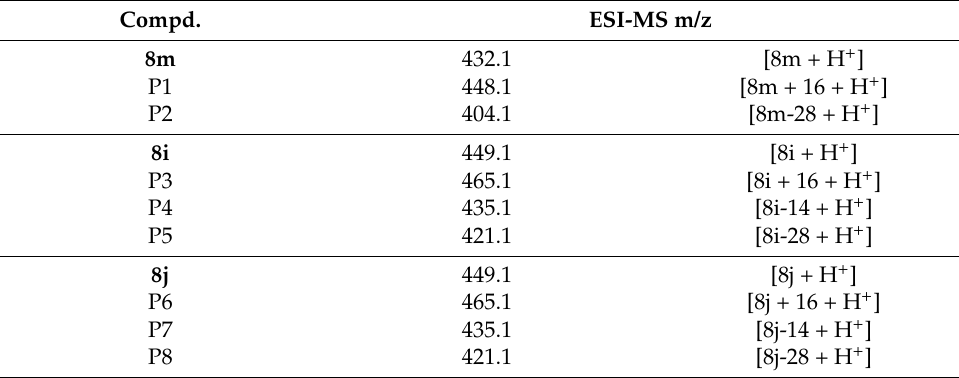
Table 8. ESI-MS m/z obtained after 8m , 8i and 8j metabolism with rat liver microsomes (RLMs) and NADPH as